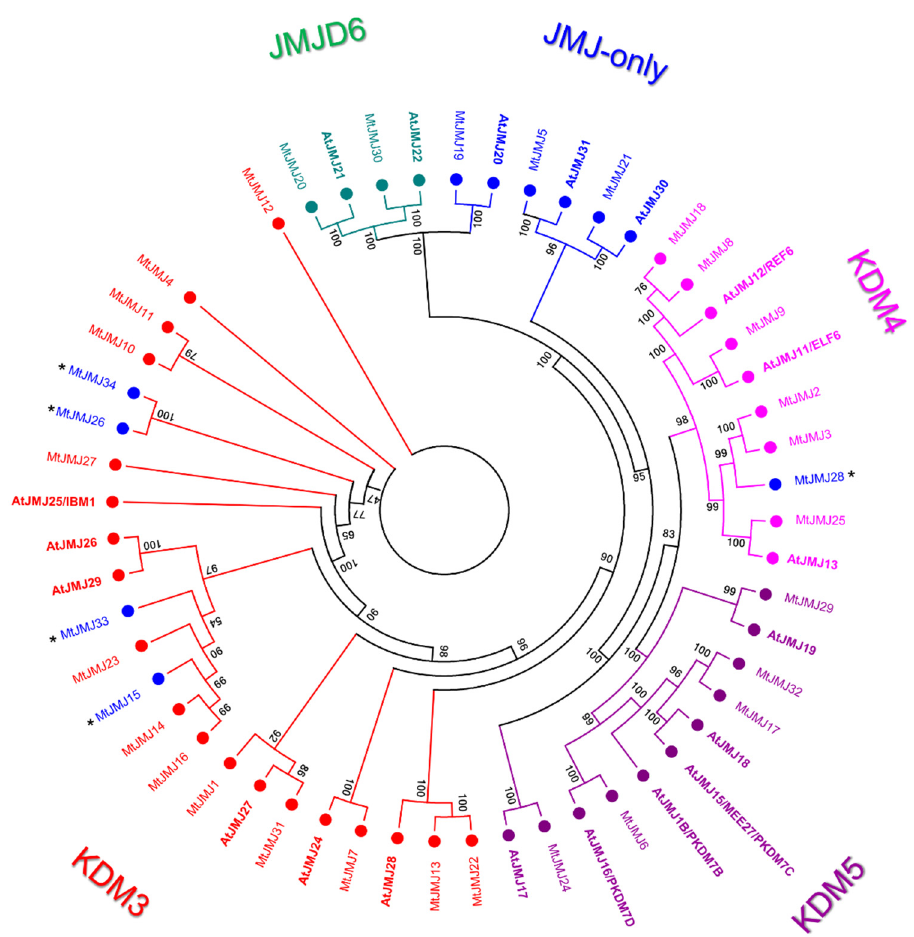
Figure 3. Phylogenetic tree of JMJ proteins of M. truncatula and Arabidopsis (in bold). The numbers near the tree branches represent bootstrap values. Asterisks indicate the proteins that underwent domain loss and that could be considered as JMJ-only proteins based on domain composition.